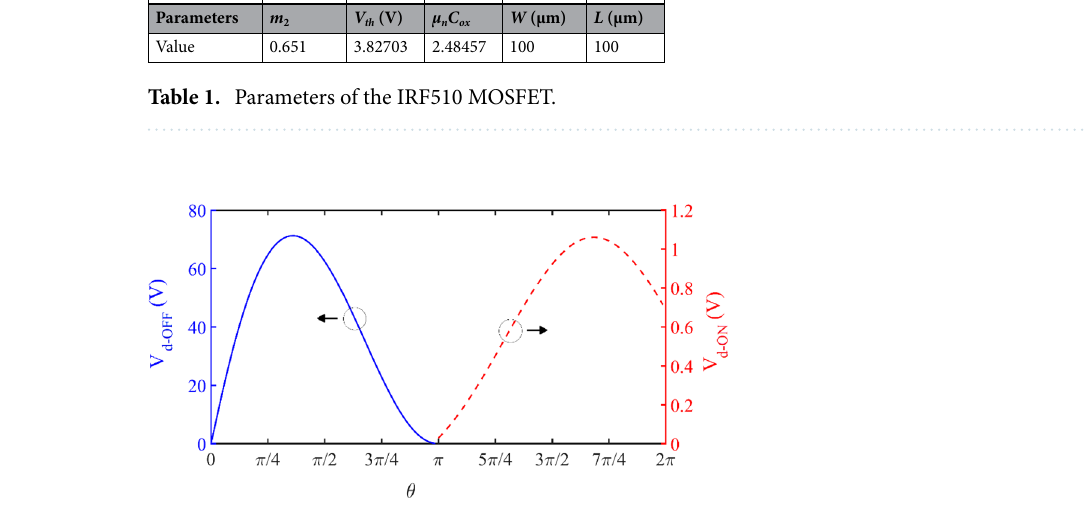
Figure 8. V d in on and OFF-states versus Ɵ